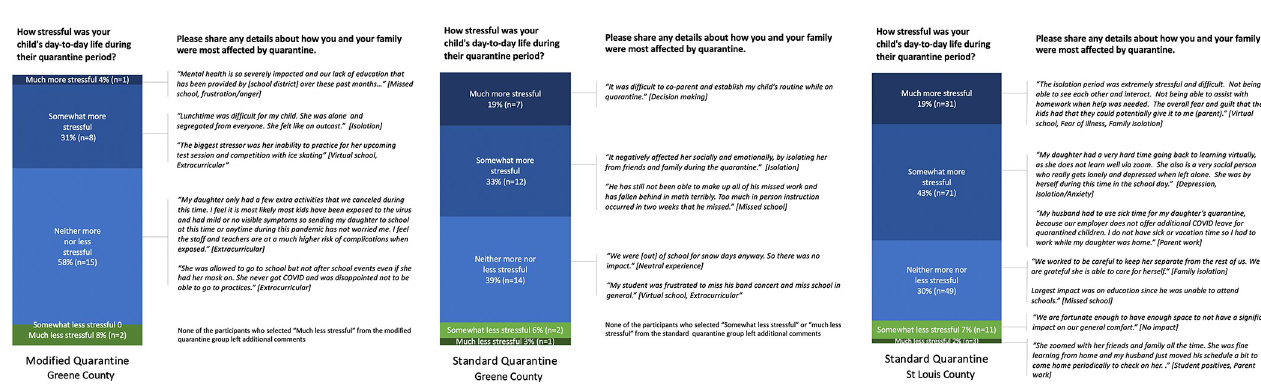
Fig 1. Reported quarantine experiences from parents/guardians of modified quarantine (a) and standard quarantine (b) in Greene County, Missouri and in standard quarantine (c) in St. Louis, County Missouri, January-March 2021.